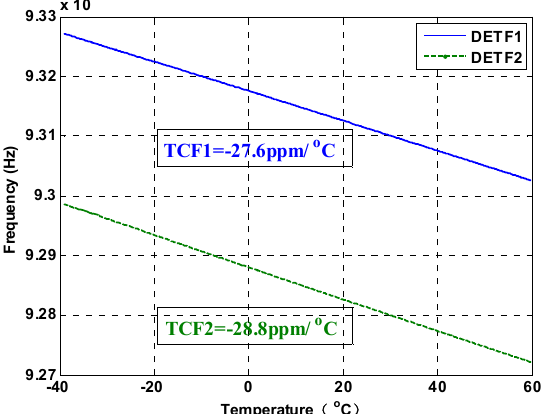
Figure 13. The resonant frequencies of the two DETFs vary with the temperature.